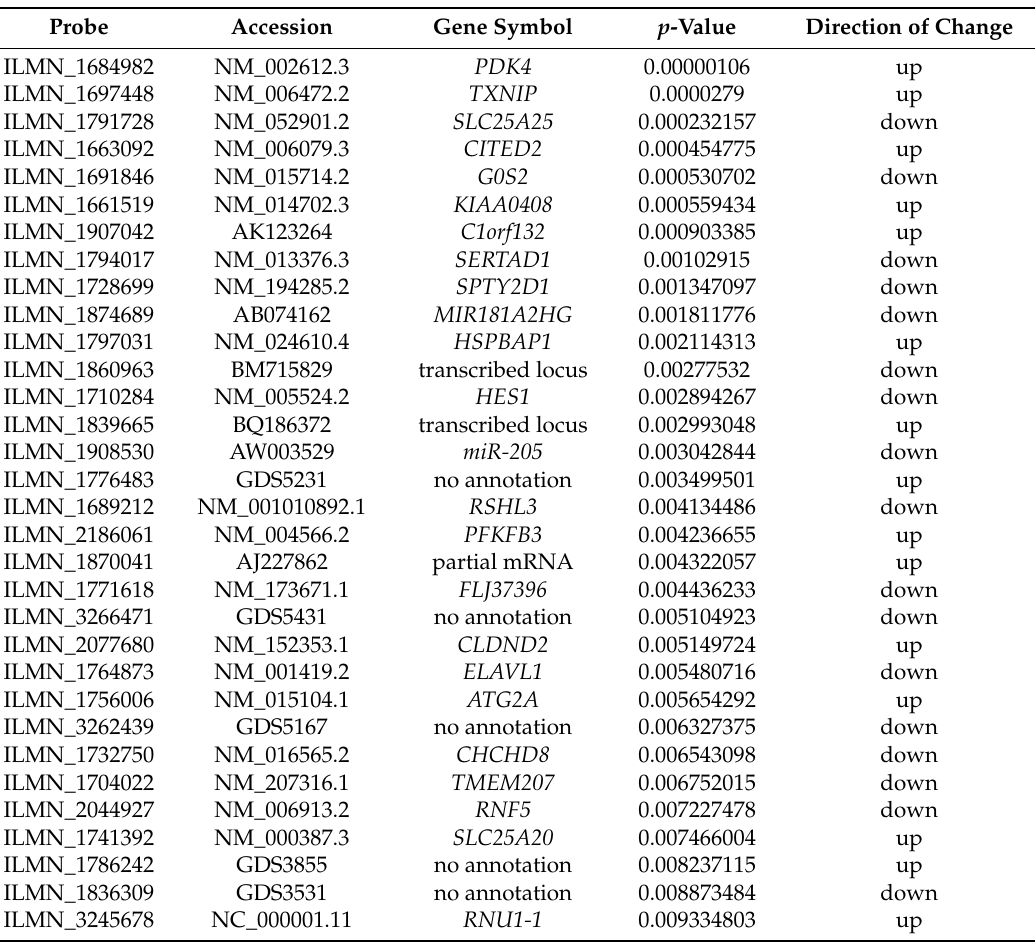
Table 4. Gene expression nominally up- or down-regulated at 3 h postprandium relative to fasting levels in nine female subjects ( t -test, p <